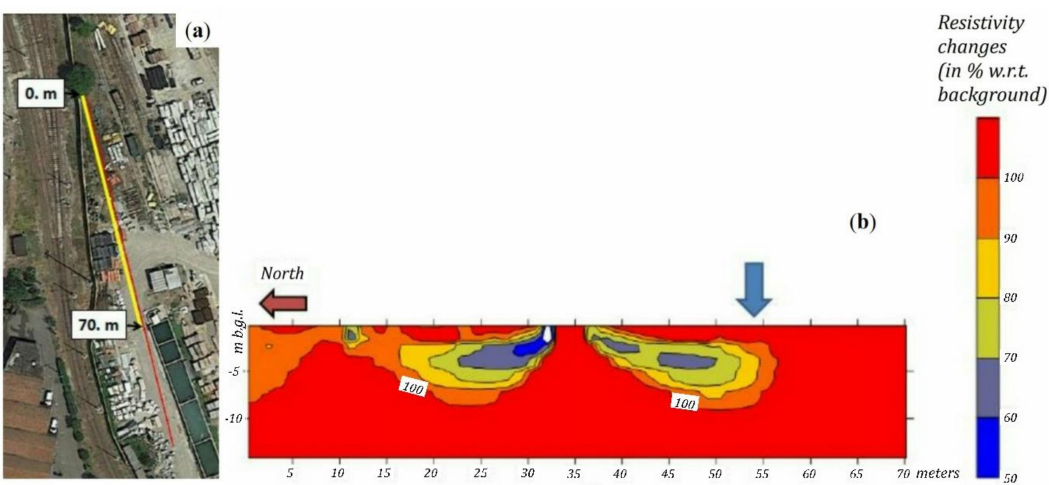
Figure 9. ( a ) Trace of the ERT line and ( b ) section illustrating resistivity changes (in % with regard to (w.r.t.) background) caused by PlumeStop ™ injection. The injection point corresponds to vertical blue